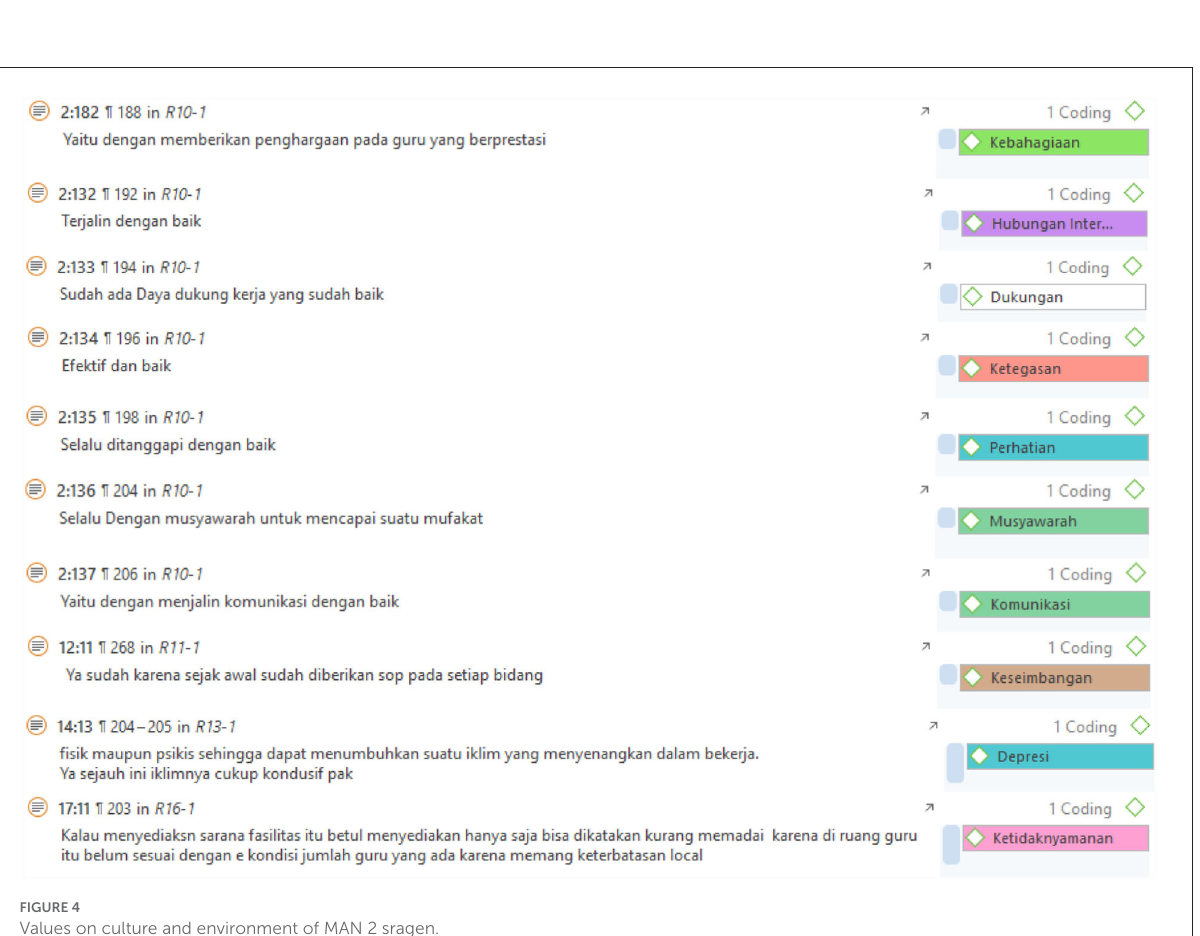
FIGURE4 Values on culture and environment of MAN 2